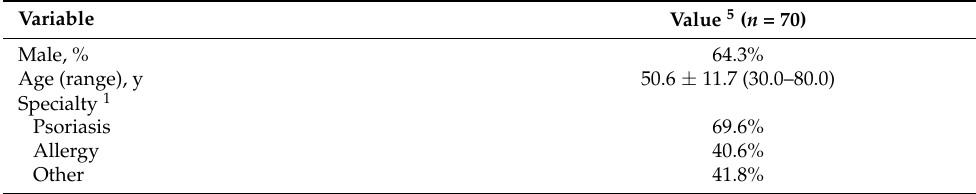
Table 2. Physician